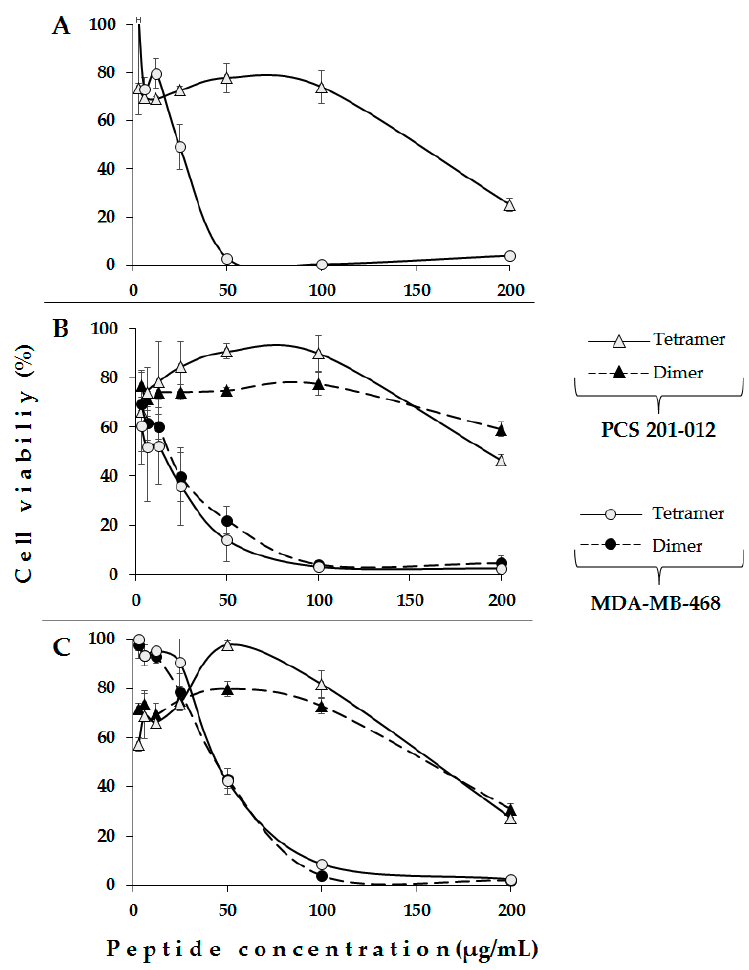
Figure 5. Comparative cytotoxic effect of LfcinB derived peptides against PCS 201-012 and MDA-MB-468 cell lines. ( A ) Peptide LfcinB (20–25) 4 ; ( B ) LfcinB (20–30) 2 and LfcinB (20–30) 4 peptides and ( C ) [Ala 19 ]-LfcinB (17–31) 2 and [Ala 19 ]-LfcinB (17–31) 4 peptides.